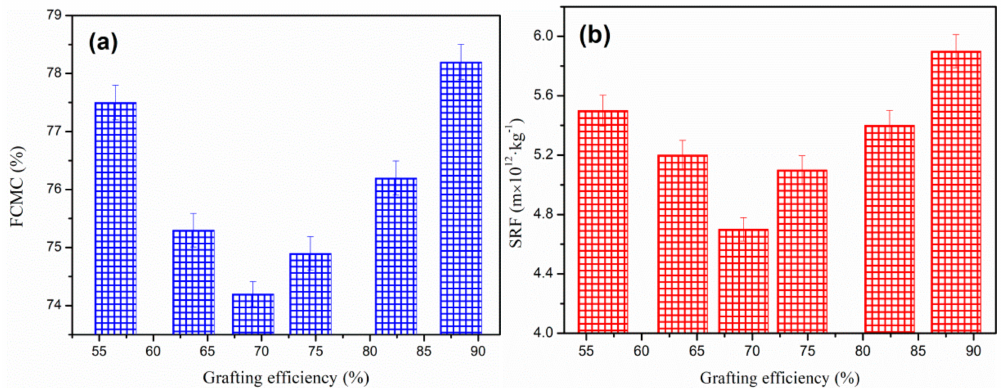
Figure 9. The e ff ect of flocculant GE on the sludge flocculation performance: ( a ) FCMC and ( b )